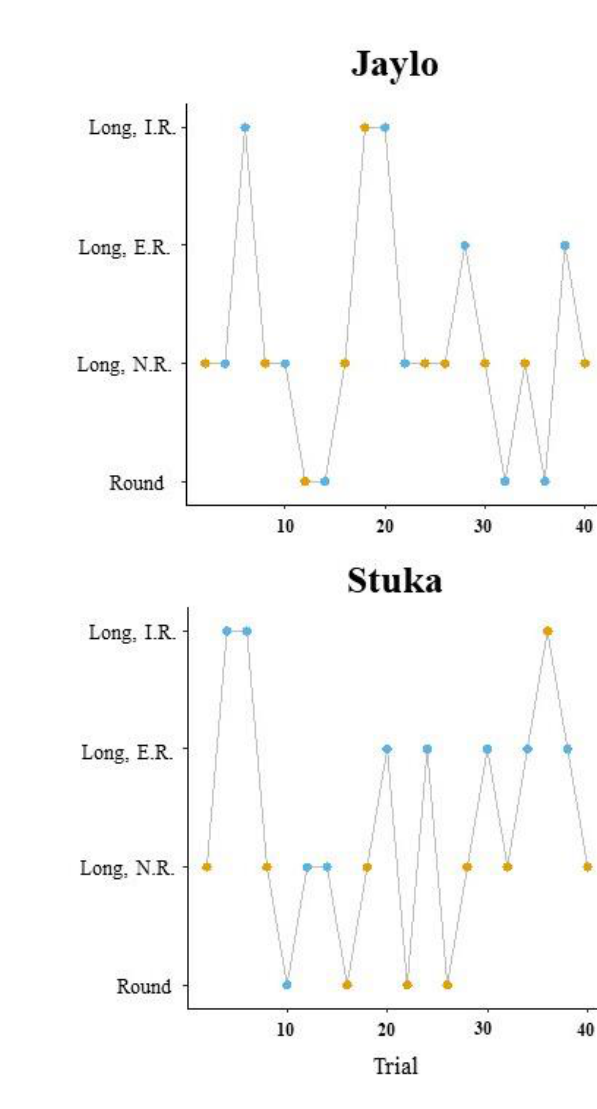
Trial by Trial Description of the Behavior in Experiment